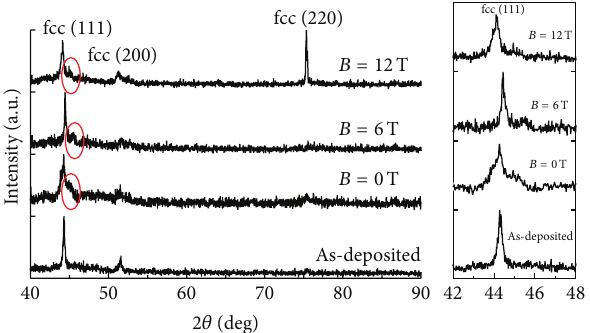
Figure 2: XRD patterns of Co-Ni-P films: (a) as-deposited and annealed at 673 K for 4 h in a magnetic field of (b) 𝐵 = 0 T, (c) 𝐵 = 6 T, and (d) 𝐵 = 12 T. The right side was the amplified zone at the angular position from 2𝜃 = 42 ∘ to 48 ∘